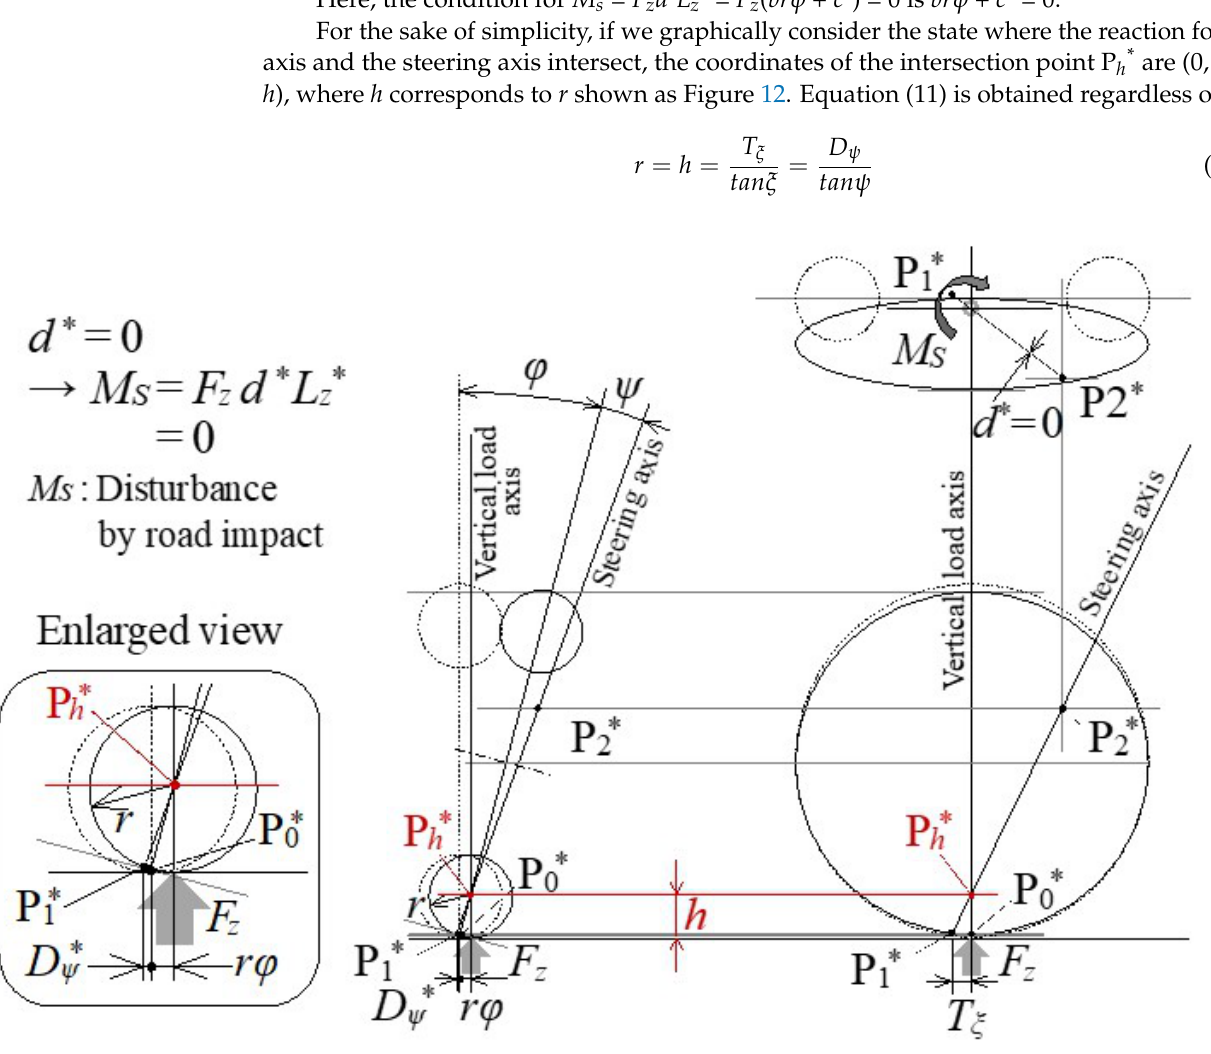
Figure 12. Steering axis to minimize M s by F z on tilted condition. The * shows when the tire is tilted